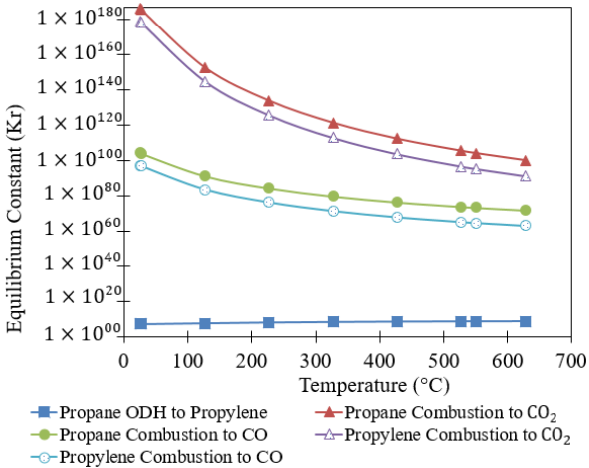
Figure 1. Chemical Equilibrium Constants as a Function of Temperature for Propane ODH under an O 2 -free Atmosphere. Total pressure: 1 atm.